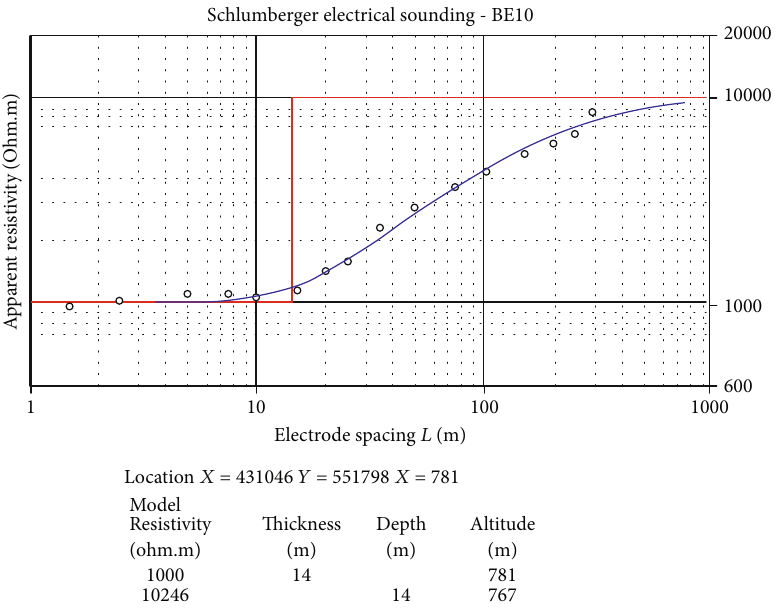
Figure 5: Sounding curve (BE